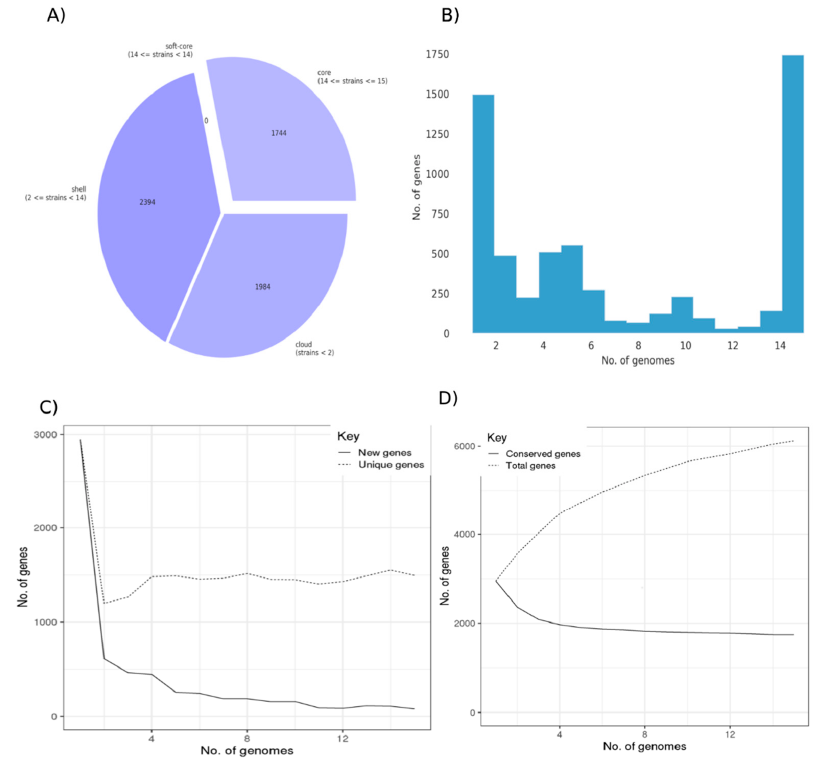
Figure 2. Pangenome of Clostridium baratii strains. ( A ) Core and accessory genes statistics. ( B ) Frequency bar graphs of the number of identical genes against the number of genomes. ( C ) Number of new genes and unique genes in the pangenome as genomes are included. ( D ) Number of conserved genes and total genes as more genomes are included in the pangenome calculation.